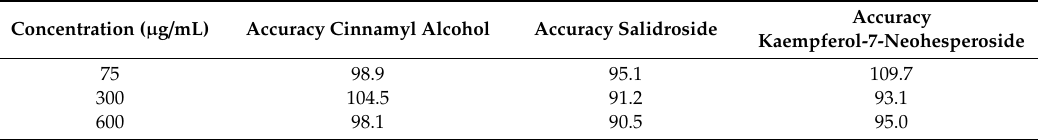
Table 1. Accuracies (%) determined for reference standards at given